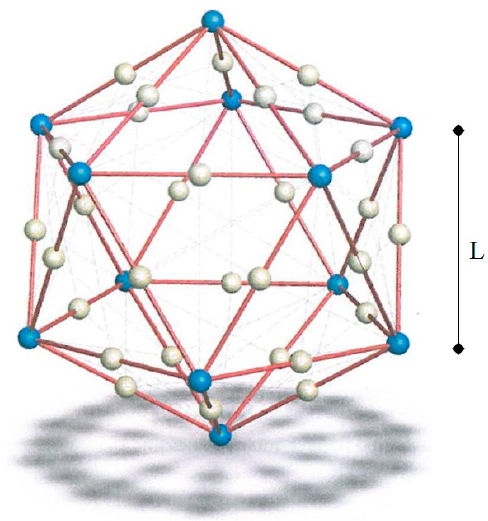
Figure 1. First variation of the icosahedral model.